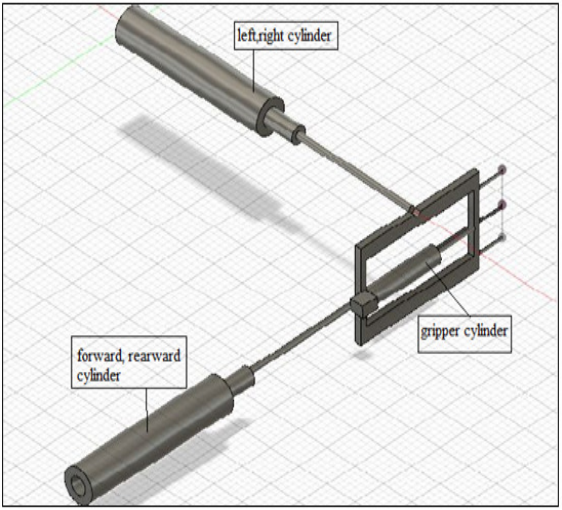
Fig. 5. The transforming unit .